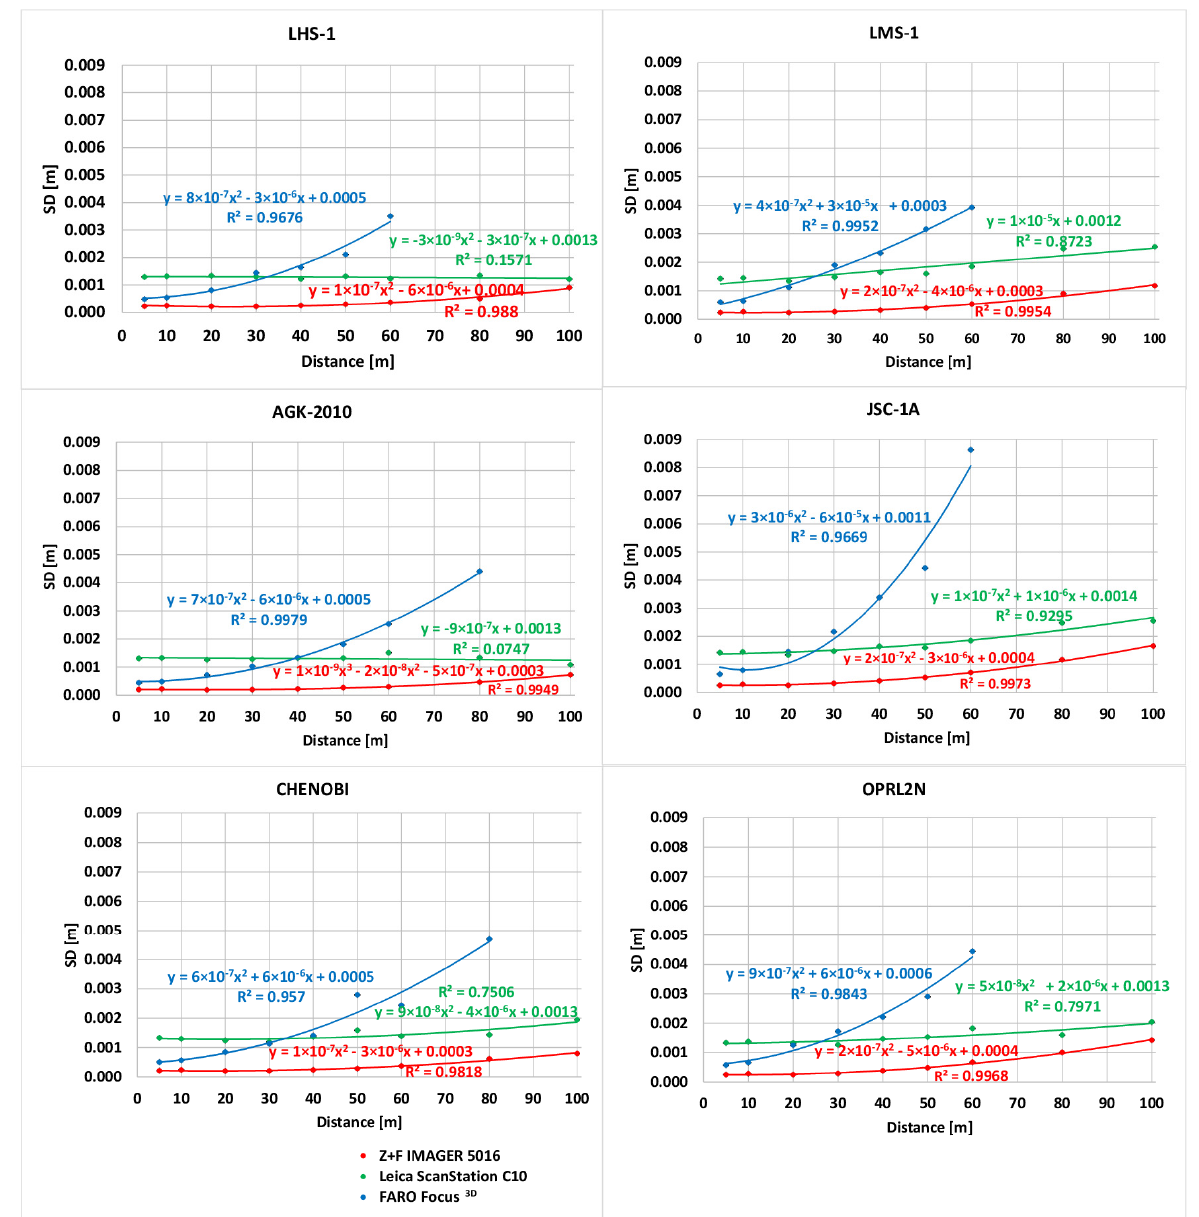
Figure 8. Error of TLS distance measurements for LSS targets.